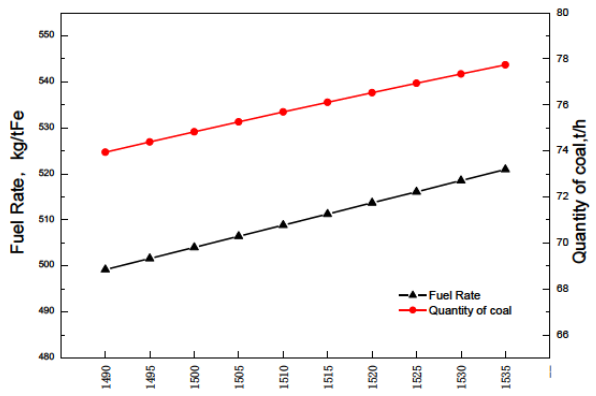
Figure 2: Estimated fuel rate and quantity of coal needed at differ- ent temperature.